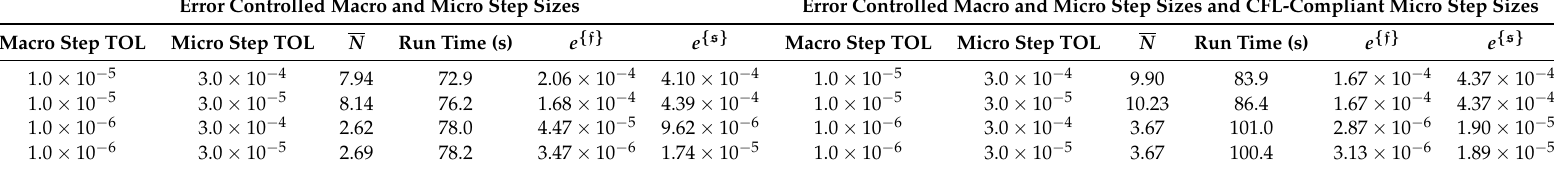
Table 3. Comparison of run time and error of different time step adaptation strategies of the 2nd order MGARK scheme applied to the piston problem, Part II. Further explanations are given in the